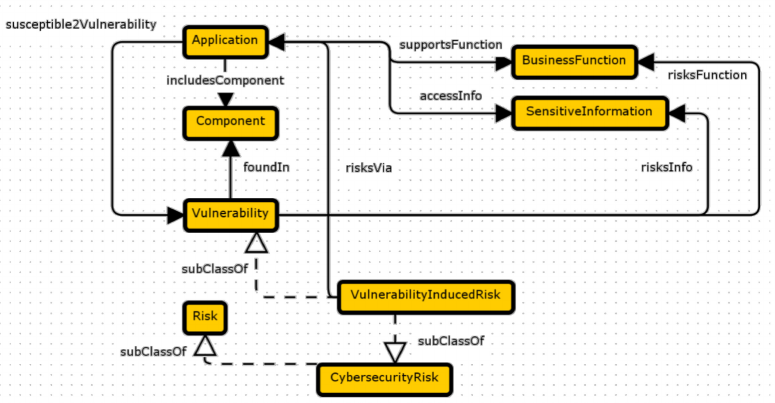
Figure 1. The vulnerability-induced risk case represented as a formal graph of meta-level concepts and relations. This graph is generated by applying the CoModIDE plugin for Prot é g é [36] to the formal ontology. The graph shows: the classes as nodes; the object properties between classes (from domain to range) as solid, annotated arrows; and subtype (subclass) relations as dashed